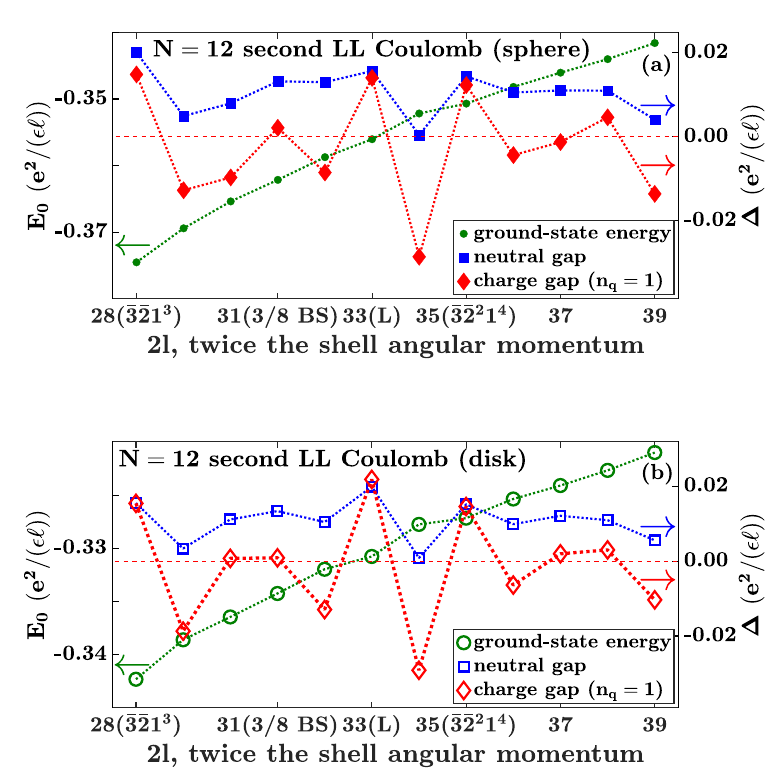
Figure 2: (color online) A plot of the second-Landau-level Coulomb ground-state energies (green dots) and neutral (blue squares) and charge (red diamonds) [ us- = 1 in Eq. (1) ] gaps for N = 12 electrons as a function of the shell-angular ing n q momentum 2 l obtained using exact diagonalization in the spherical geometry with the spherical [ top panel (a) ] and disk [ bottom panel (b) ] pseudopotentials. A pro- nounced downward cusp in the ground-state energy and robust charge and neutral gaps are seen at 2 l = 35 which corresponds to the ¯3¯2 2 1 4 state at 3 / 8. For refer- ence we have also marked other states such as 2 l = 28 [ ¯3¯21 3 state at ν = 6 / 13 (¯3¯21 3 ) [ 1 ]] , 2 l = 31 [ ν = 3 / 8 Bonderson-Slingerland (3 / 8 BS) [ 19 ]] and 2 l = 33 [ ν = 1 / 3 Laughlin (L) [ 4 ]] . The dotted lines are a guide to the